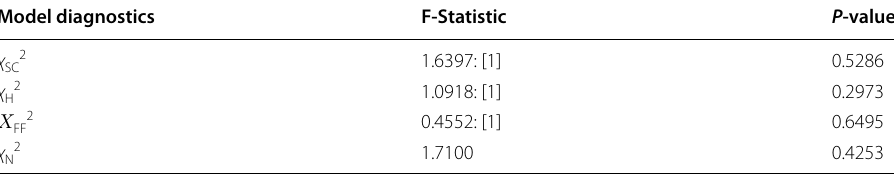
Table 5 Diagnostic